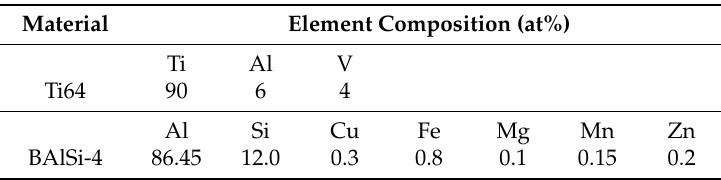
Table 1. Elemental composition of Ti64 and